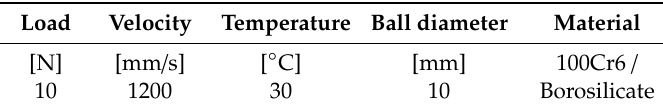
Table 3. Tribological parameters.